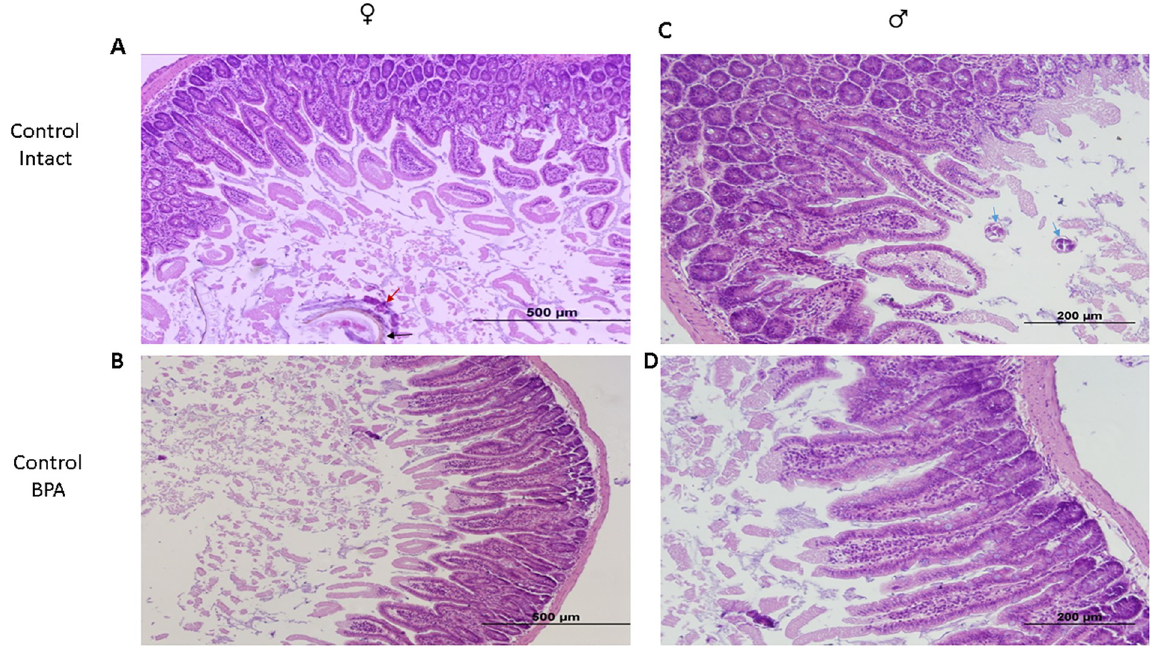
Fig 2. Histological evaluation of the duodenal inflammatory infiltrate associated with T . spiralis infection. Photomicrograph of longitudinal sections of the proximal duodenum of male and female control infected (C-I) mice (a, c, respectively), and male and female BPA infected (BPA-I) mice (b, d, respectively). The black arrow indicates T . spiralis larvae, red arrow indicates eosinophils attached to the parasite, and blue arrows indicate encysted larvae.